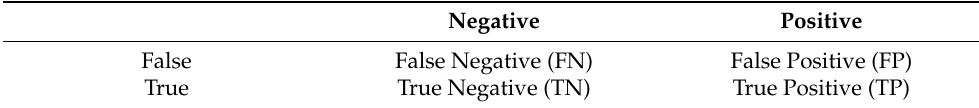
Table 2. Four possible outcomes of fire identification. Negative